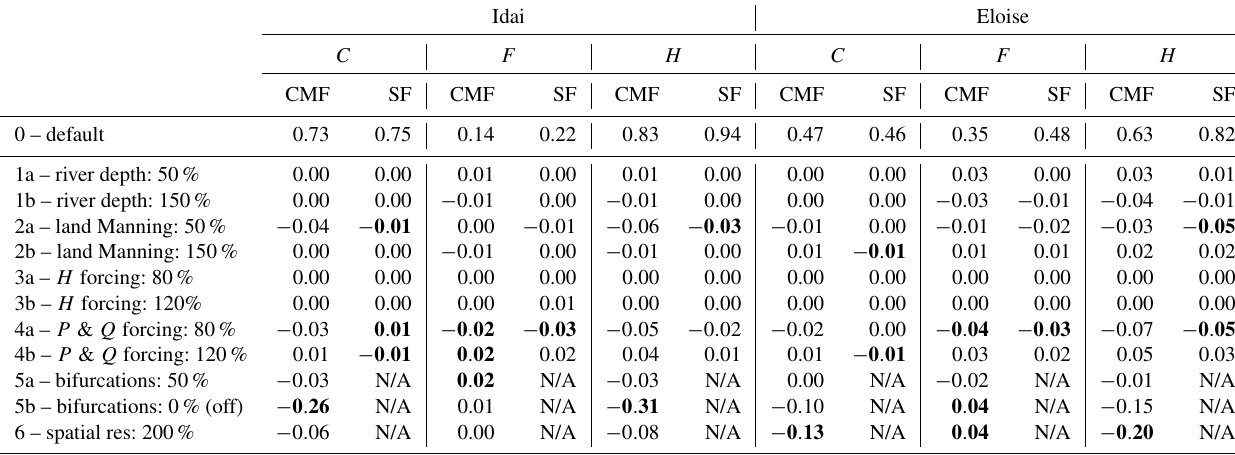
Table 5. Sensitivity analysis of model skill for CaMa-Flood (CMF) and SFINCS (SF) to river depth, Manning roughness, coastal driver ( H forcing), pluvial and fluvial drivers ( P & Q forcing), bifurcations, and spatial resolution. The model skill is evaluated in terms of the critical success index ( C ), hit rate ( H ), and false-alarm ratio ( F ) based on a comparison of the multi-day maximum simulated and satellite-derived flood extents. For scenarios 1–6 the difference in skill relative to the base scenario is shown; the largest absolute differences per column are highlighted in bold.